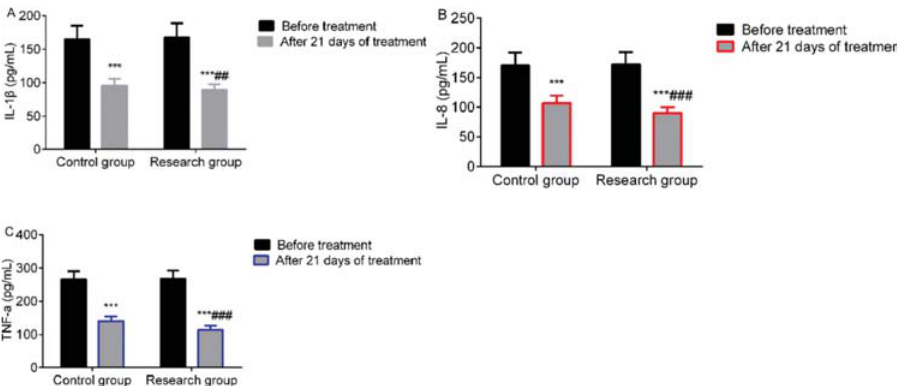
Figure 4 - Comparison of the levels of inflammatory markers. A: IL-1 b levels; B: IL-8 levels; C: TNF- a levels. *** indicates p o 0.001 when compared to levels before treatment; ### indicates p o 0.001 when compared to the control group. IL-1 b : Interleukin-1 b ; TNF- a : Tumor necrosis factor- a .